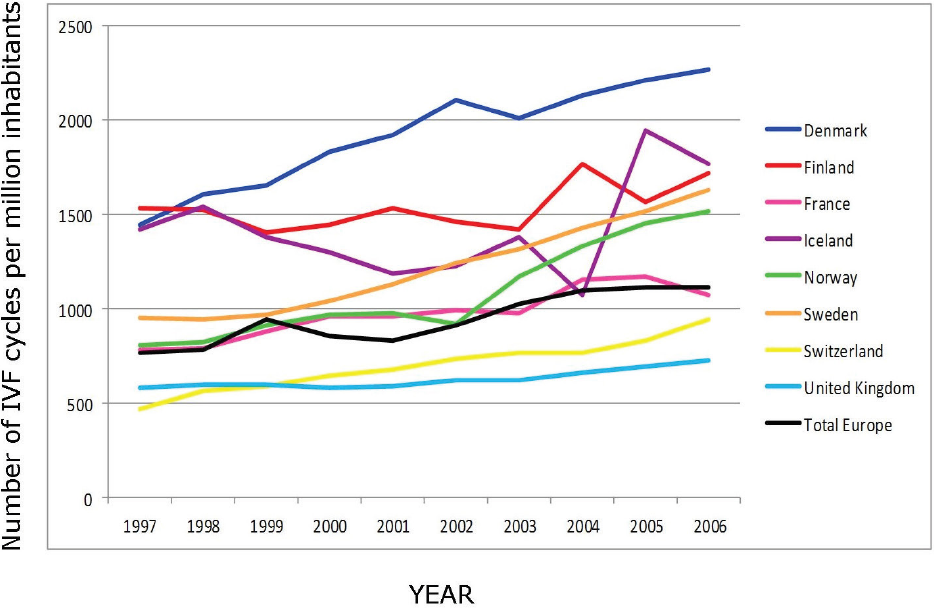
Figure 1. Number of IVF Cycles per Million Inhabitants in Various European Countries from